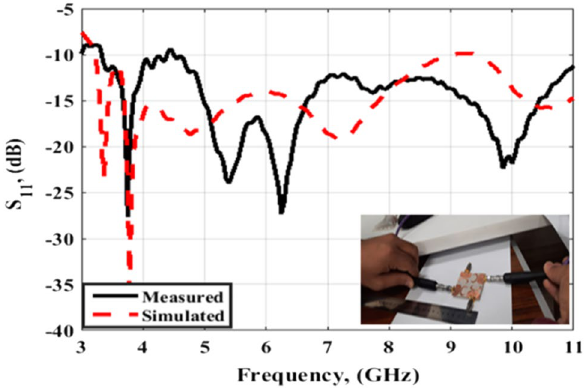
Figure 8. S 11 outcomes of the flexible MIMO antenna.